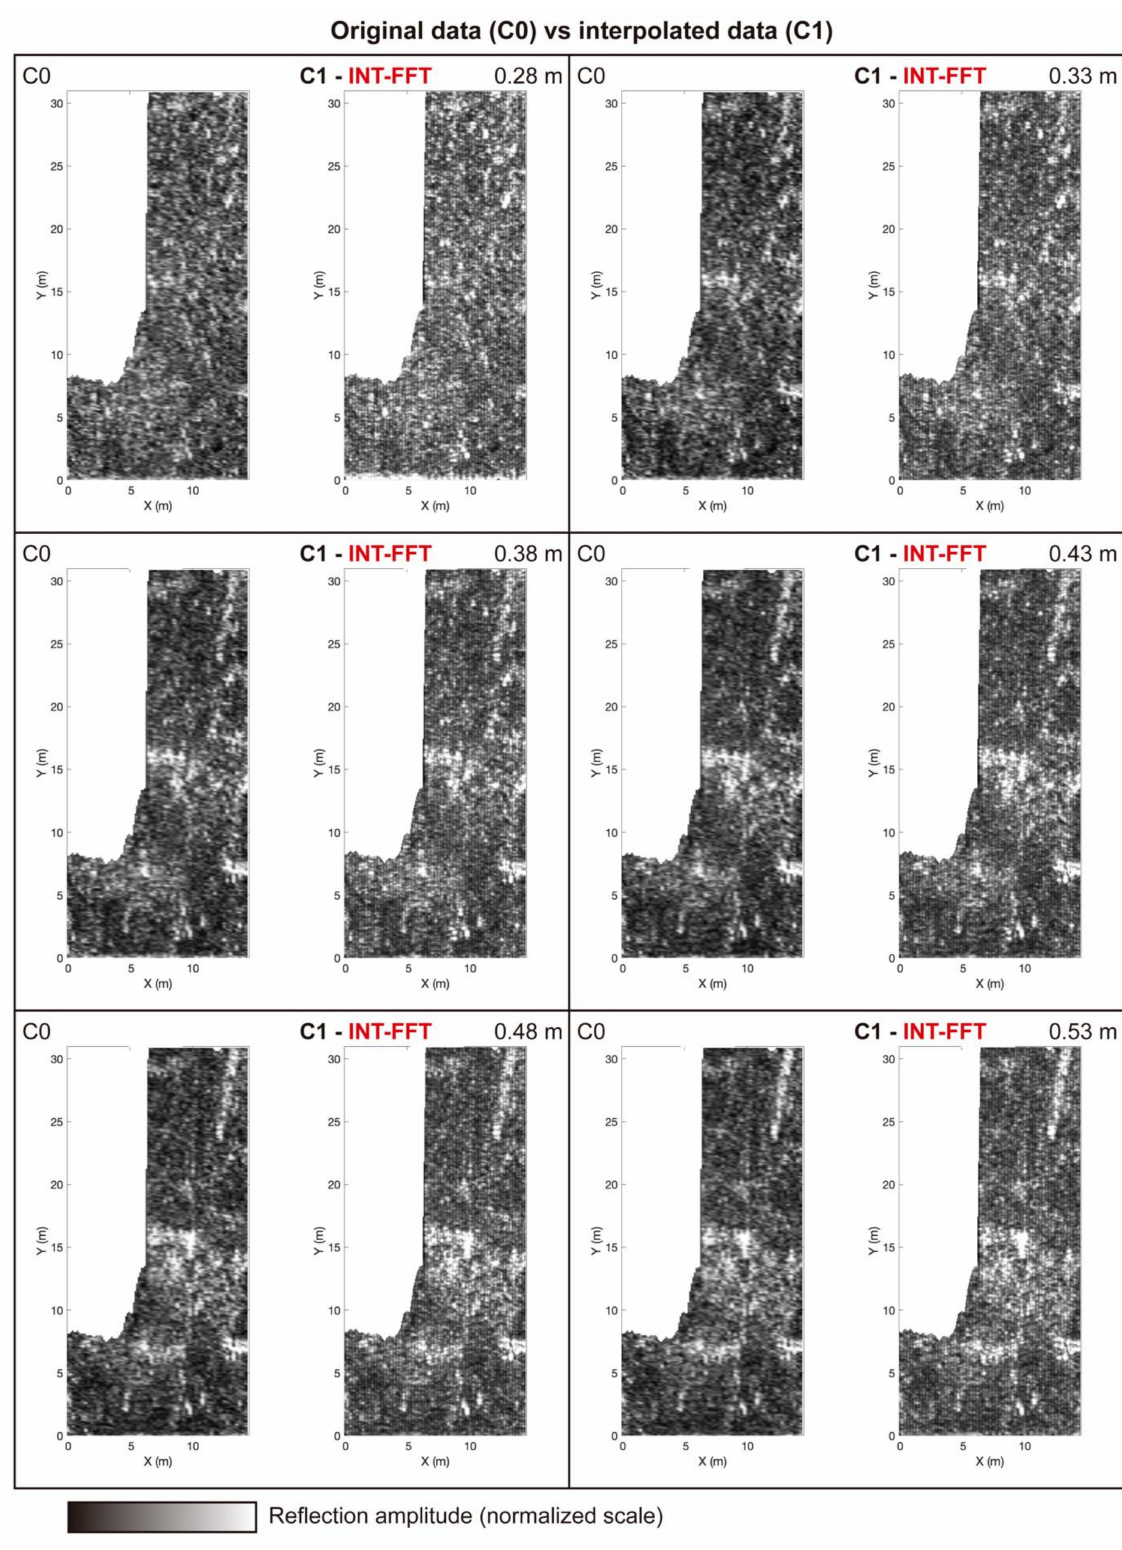
Figure 7. Differences between original data (C0—d = 0.250 m) and interpolated data (C1—d = 0.125 m). We can observe an increase in the definition of reflector alignments corresponding to wall-like structures after increasing the data density with the INT-FFT